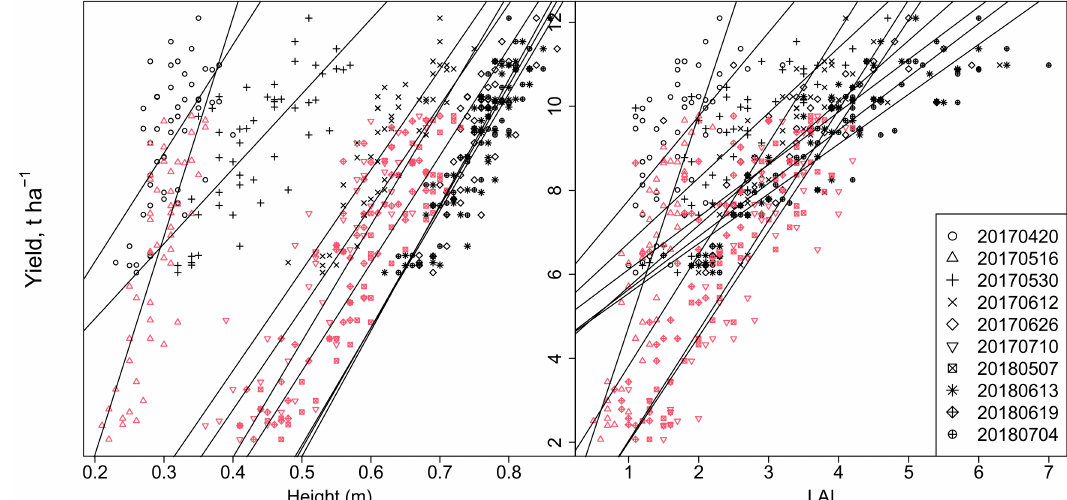
Figure 4. Relationships between yield and height ( Left ) and yield and LAI ( Right ) during different days of the growing season (symbols) vary in different years (2017, black; 2018, red). Regression lines are shown for linear models fitted to individual days. The date of measurement is indicated by symbols and shown in the legend (format